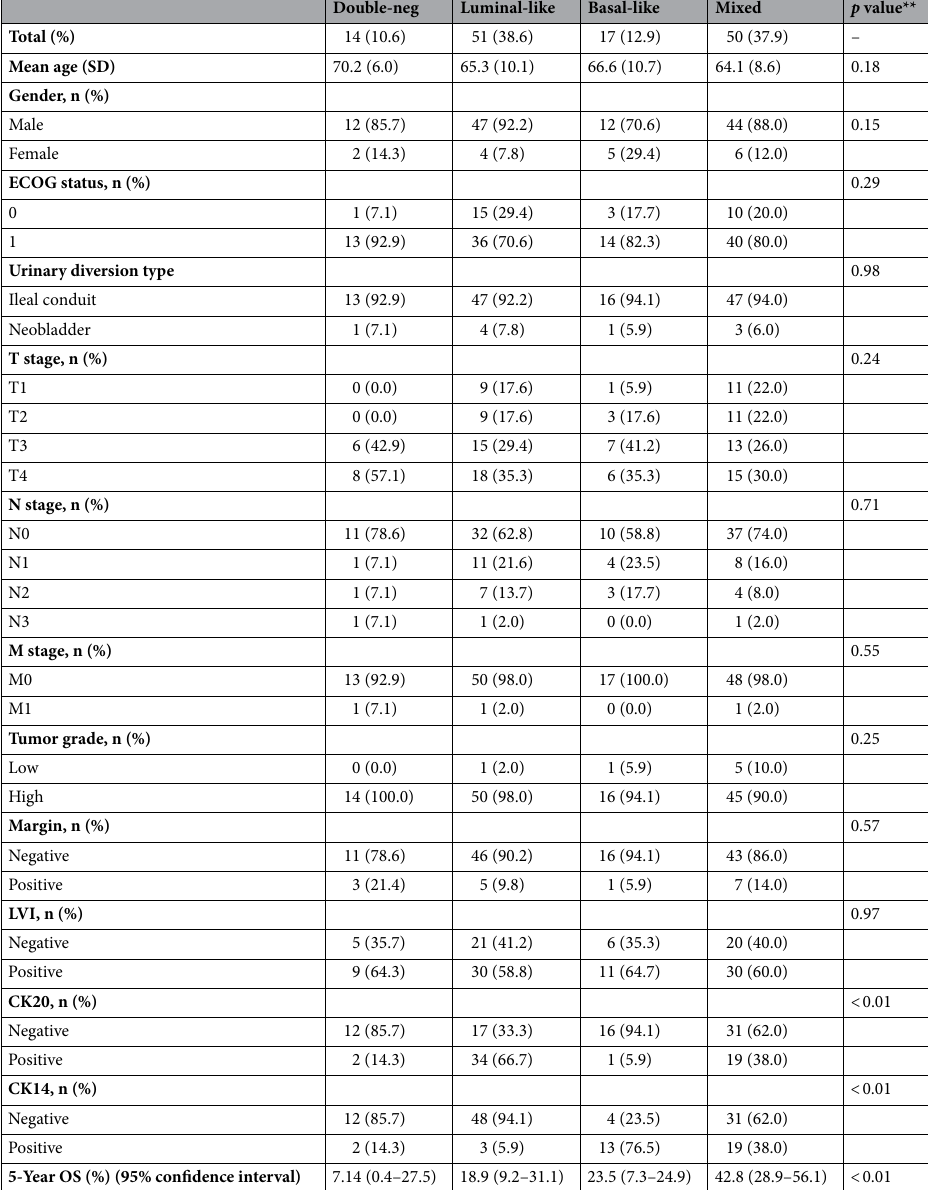
Table 3. Patient characteristics and classification by IHC subtype according to GATA3 and CK5/6 expression. * p value by Chi-square or Fisher’s exact test; ECOG status: Eastern Cooperative Oncology Group performance status; LVI: lymphovascular invasion; OS: overall